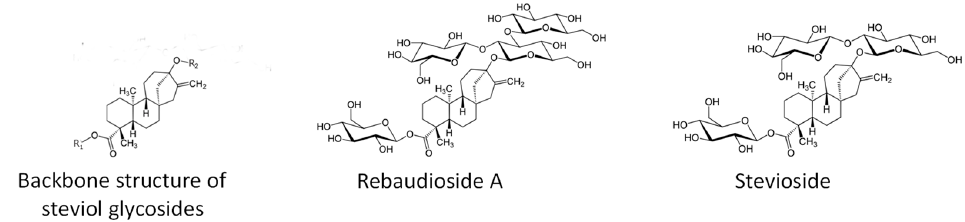
Figure 1. Backbone structure of steviol glycoside and chemical formulas of rebaudioside A and stevioside.